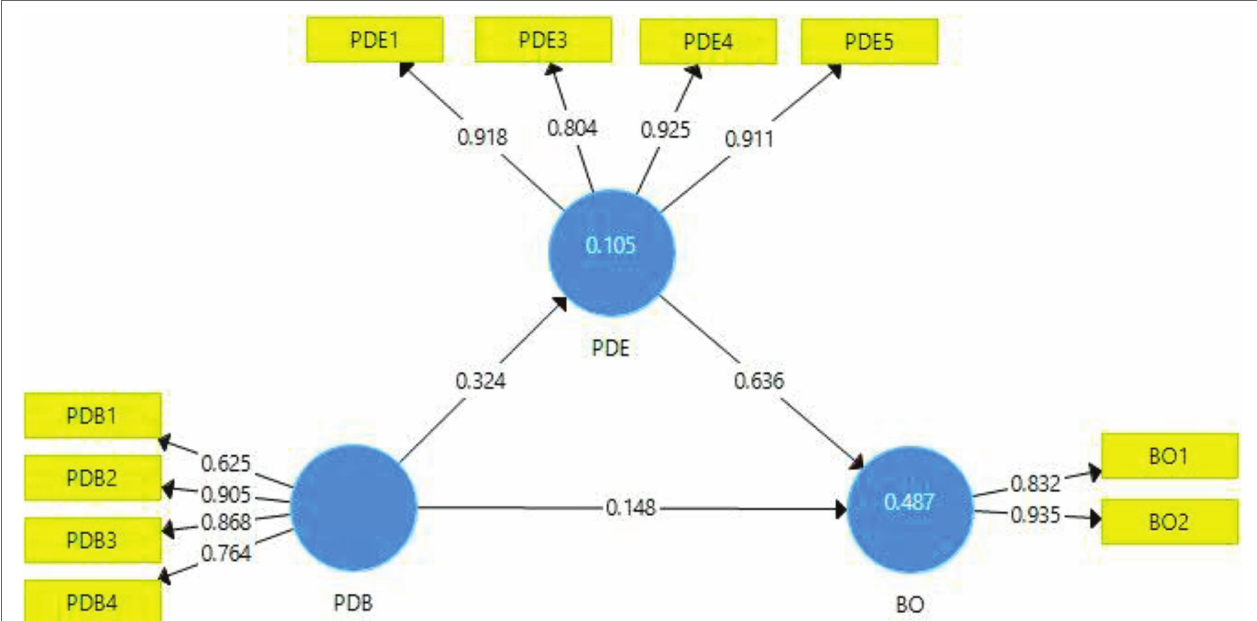
FIGURE 2 | Measurement model.